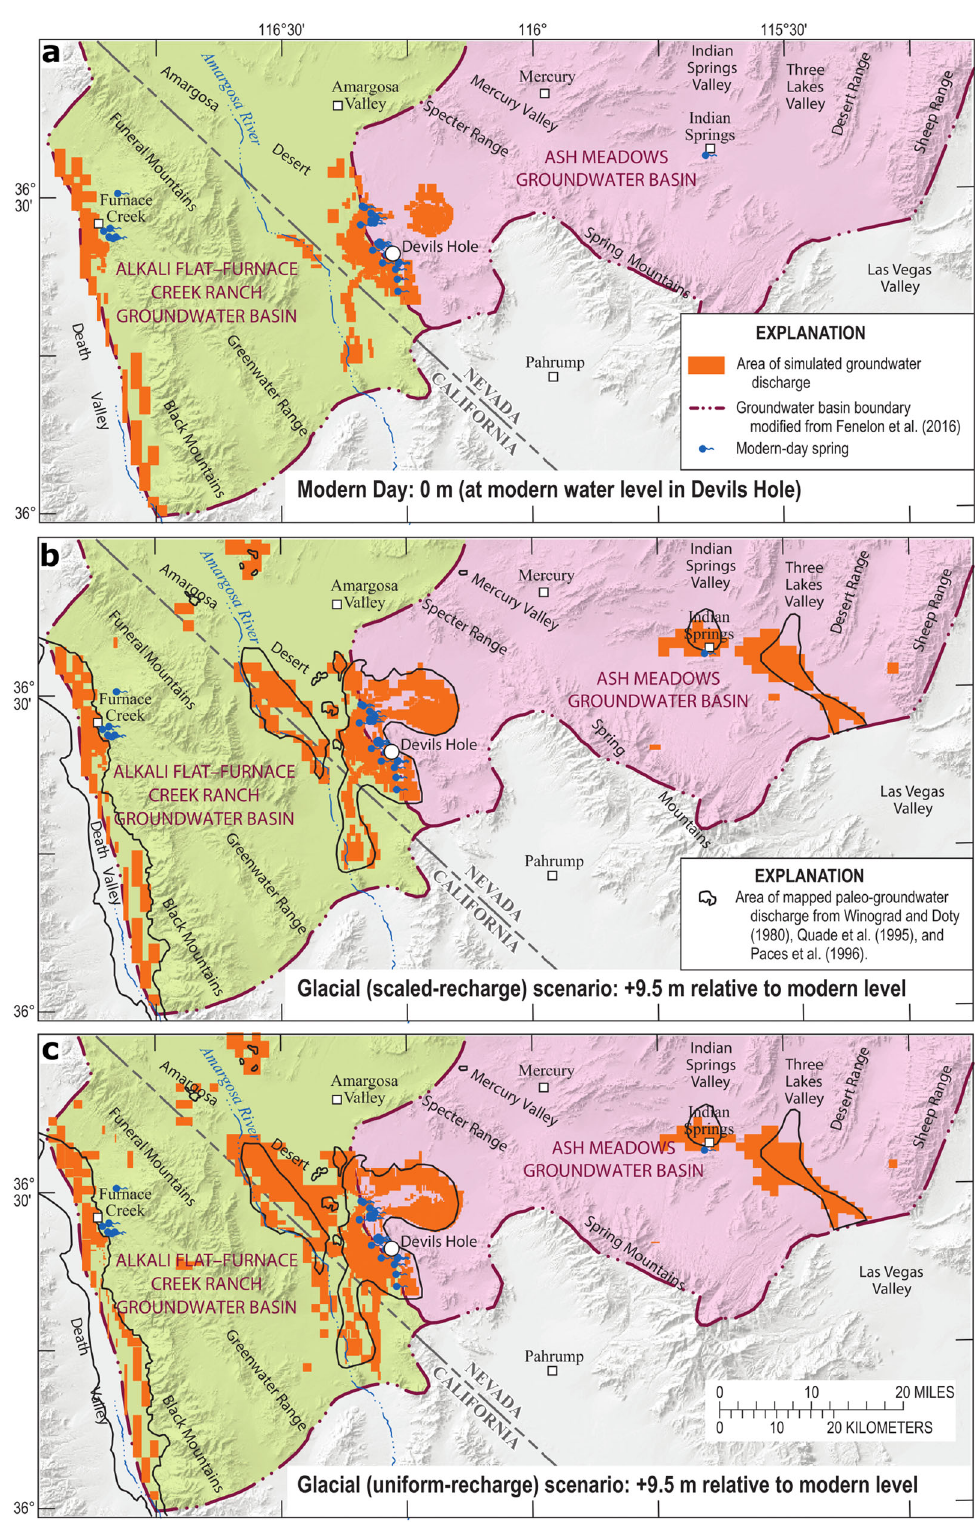
Fig. 4 Groundwater-discharge areas for modern-day and glacial condition. Simulated groundwater-discharge areas for modern-day ( a ), glacial (scaled- recharge; b ), and glacial (uniform recharge; c )